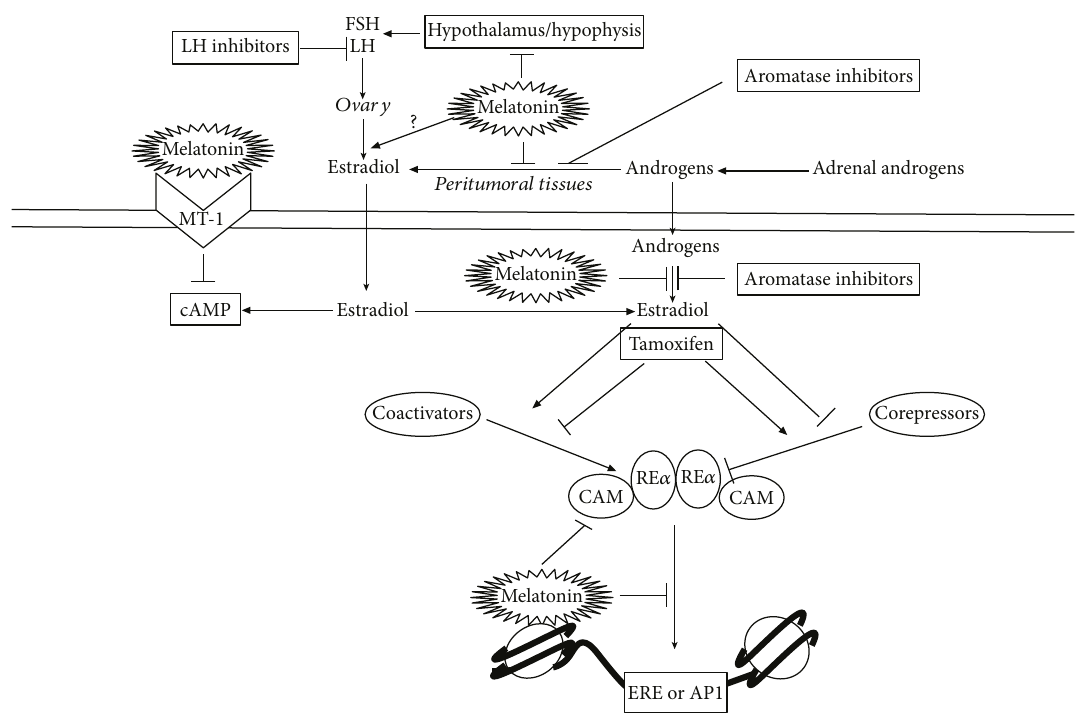
Figure 1: Melatonin antiestrogenic actions in estrogen-dependent human breast cancer cells: downregulation of the neuroendocrine/ reproductive axis. Inhibition of the enzymes necessary for the conversion of adrenal androgens into estrogens in tumor surrounding tissues and in estrogen-dependent breast cancer cells. Inhibition of adenylate cyclase through binding to the MT-1 membrane receptor in epithelial malignant cells, counteracting the stimulatory e ff ect of estradiol. Binding to the calmodulin-ER α complex, provoking destabilization of the estradiol-ER α complex, preventing its binding to DNA in both estrogen response element- (ERE-) and activator protein 1- (AP1-) containing promoters (whereas tamoxifen directly binds to the estrogen receptor, interfering with the binding of